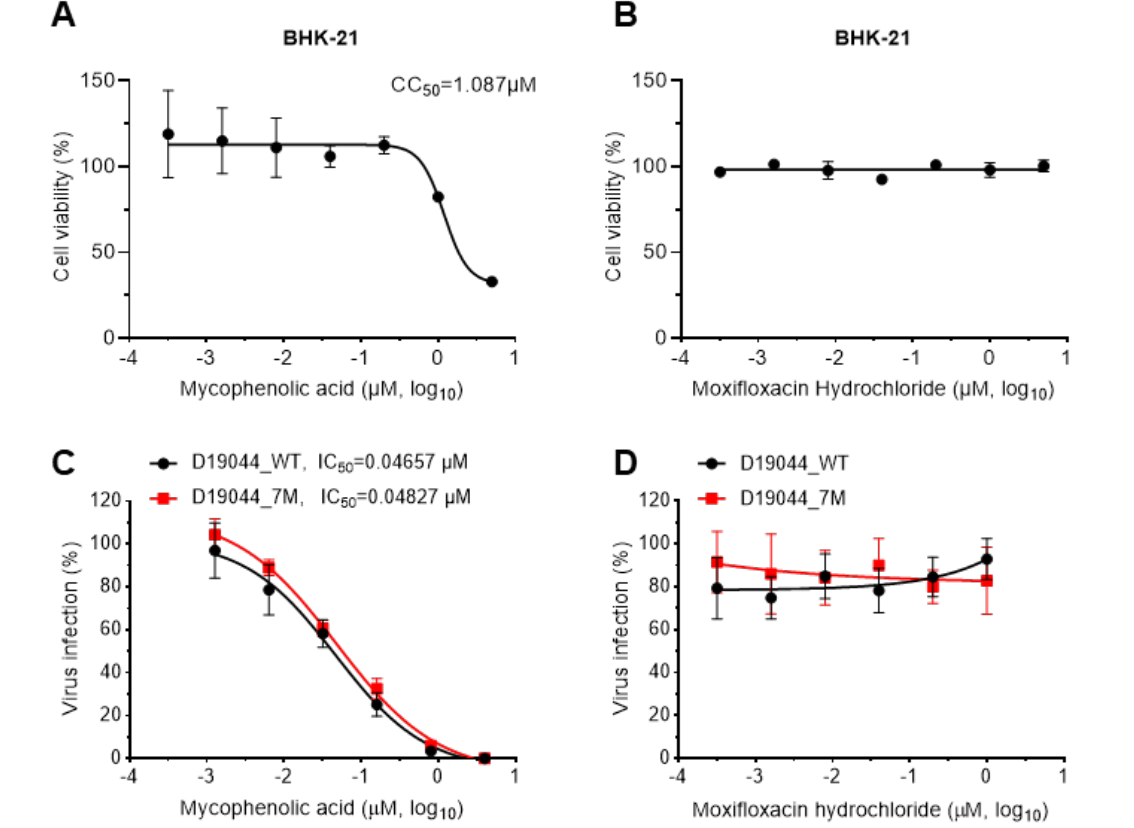
Figure 6. D19044 was inhibited antiviral compound in a dose-dependent manner. ( A , B ) The cell viability of BHK-21 cells under the treatment of mycophenolic acid (MPA) and moxifloxacin hydrochloride. ( C ) MPA inhibited D19044_7M and D19044_WT in a dose-dependent manner with comparable IC 50 (0.04827 µ M and 0.04657 µ M). ( D ) Moxifloxacin hydrochloride did not inhibit D19044_7M and D19044_WT viruses. In C and D , BHK-21 cells were infected with D19044_7M and D19044_WT with MOI of 0.1 for 2 h, and then incubated with drugs of different concentrations for 48 h. The infection rates were examined by IFA and normalized to the nontreated mock controls. The means ± SEM of four determinations are shown.